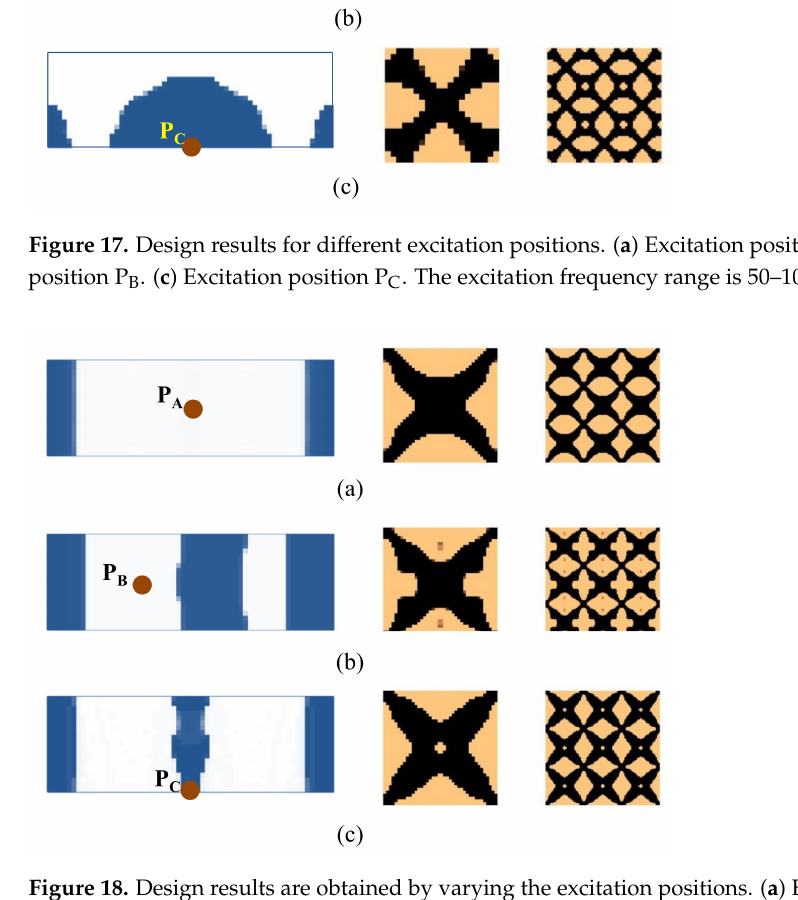
Figure 18. Design results are obtained by varying the excitation positions. ( a ) Excitation position P A . ( b ) Excitation position P B . ( c ) Excitation position P C . The excitation frequency is 300